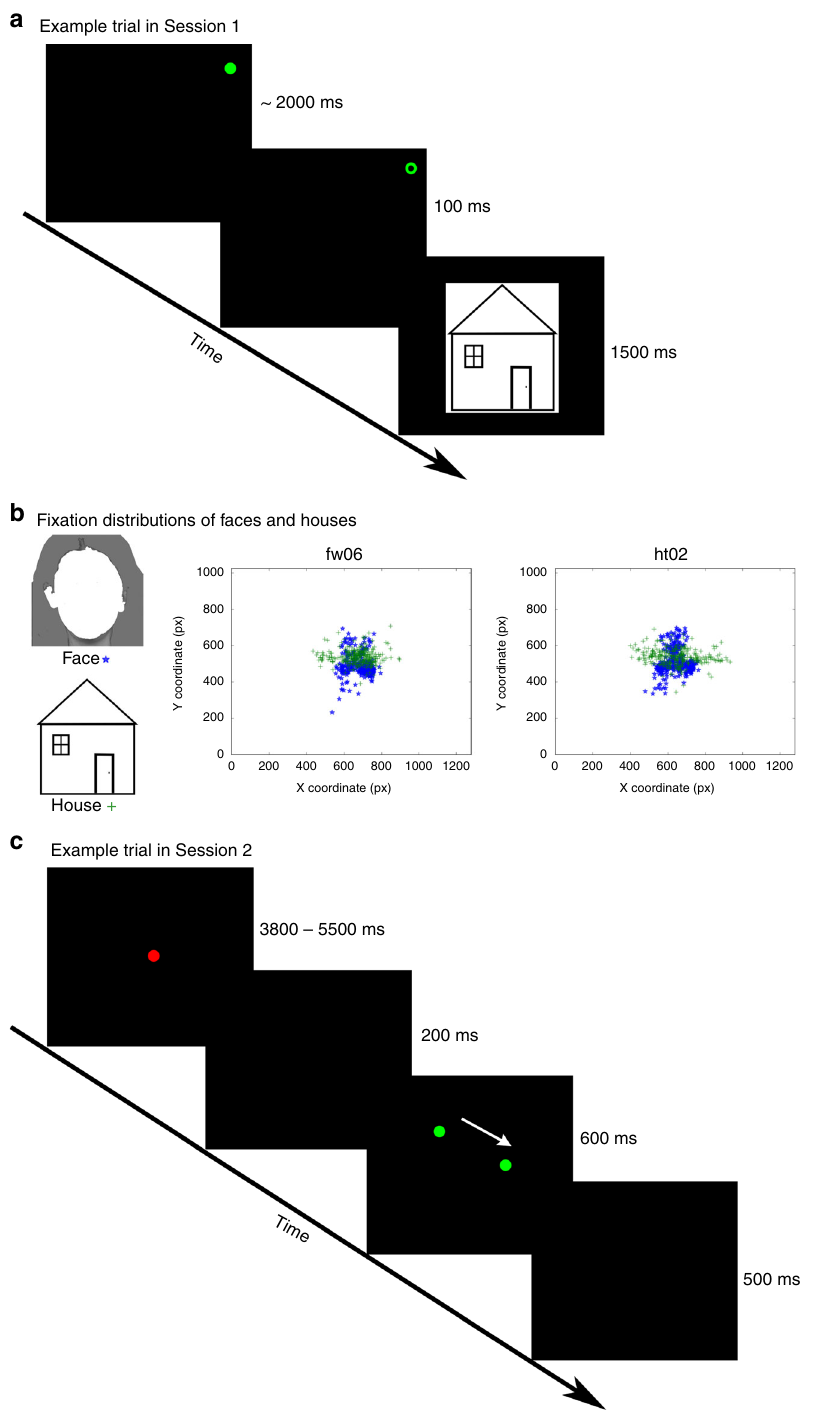
Fig. 5 Experimental design and fi xation patterns in Experiment 3. a An example trial in the gaze-recording session of Experiment 3. In each trial, participants were asked to fi xate the green dot which was located at one of the four screen corners, and detect a small black dot inside the green dot. When the face or house appeared, participants had to indicate if the current picture was new or one of the previously presented pictures. This task required attentive viewing for face or house recognition. b A face example (shown as contour here for privacy protection) and a cartoon example of the house from the picture set (left), and the fi xation patterns collected from the 600 ms interval after stimulus onset from two participants (collapsed over all face and house pictures, right). These fi xation patterns were used for the scanner session of Experiment 3. c An example trial in the scanner session of Experiment 3 that was conducted 1 week after the gaze-recording session. A red central fi xation dot was followed by a sequence of green moving dots, representing the respective fi xation pattern. In 20% of the trials, equally probable in the four conditions (Self-face, Self-house, Other-face, Other-house), a small black dot centered inside the fi xation dot (equally probable for the red central fi xation dot and the green moving dot) served as target. Subjects were instructed to respond with a forced choice button press to target presence. The white arrow only indicates the track of the green dot, but was not presented in the actual